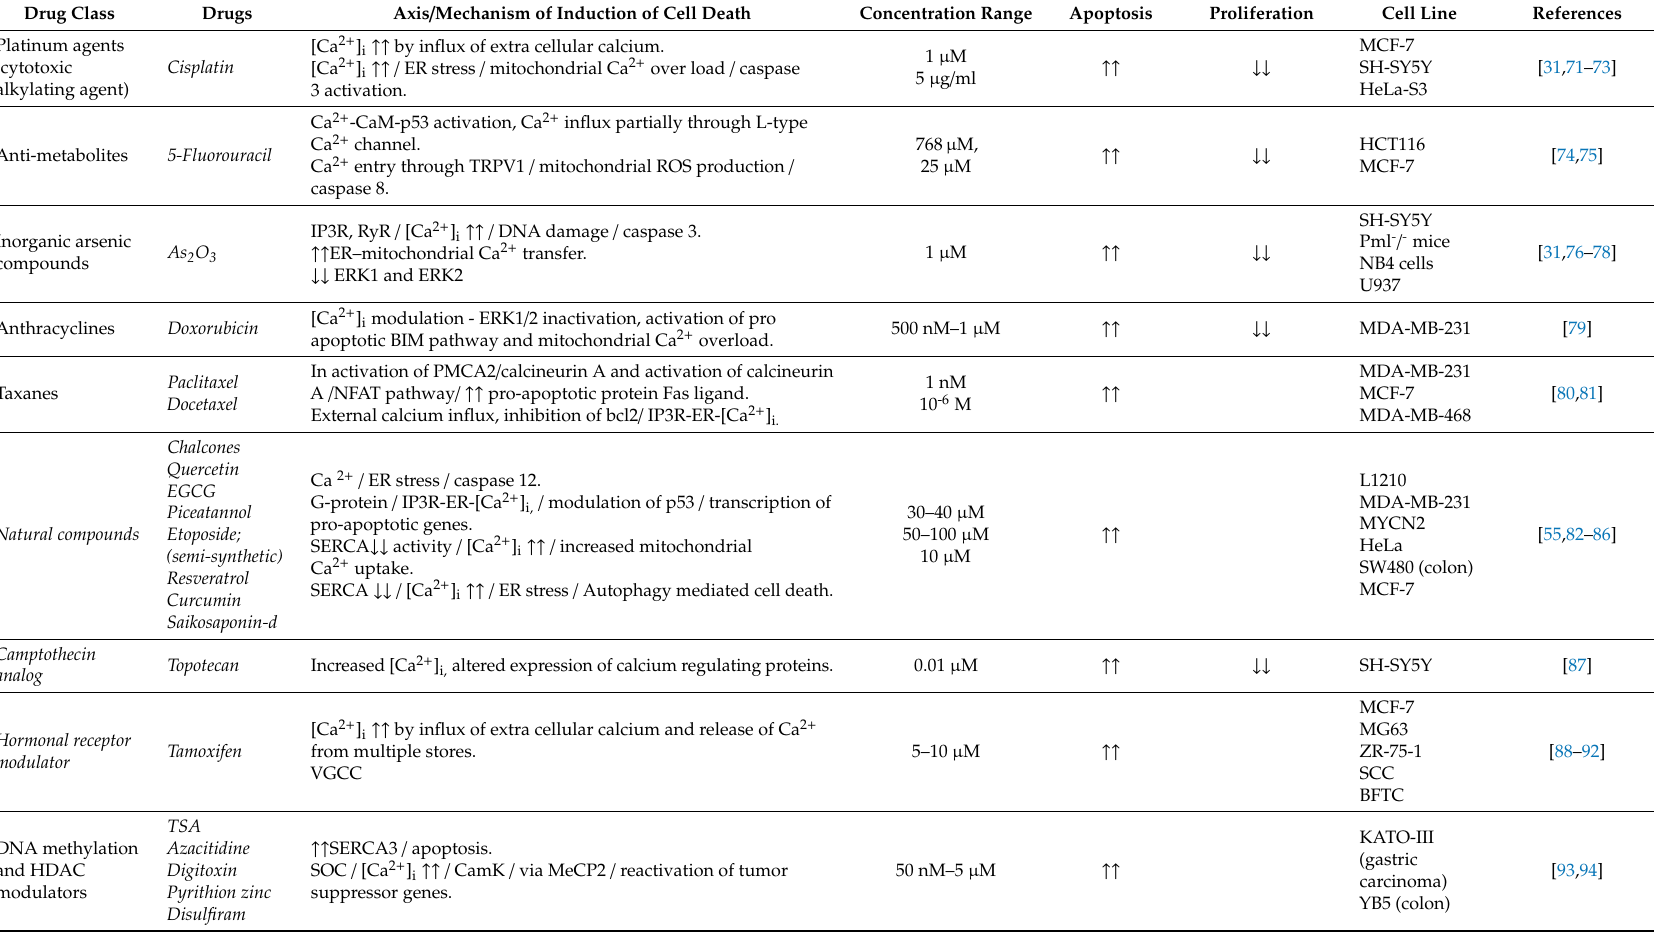
Table 1. Interference of anti-cancer agents with di ff erent mechanisms of calcium homeostasis. This table illustrates which calcium mediating processes are involved, the actual concentrations (doses) needed, the experimental model, and whether apoptosis or proliferations are